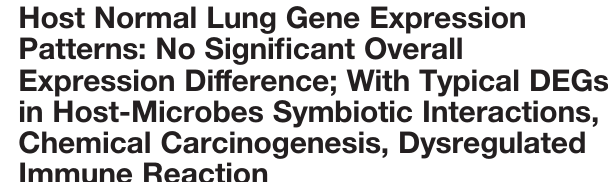
( Figure 3C , Table S35 ), which consisted with others